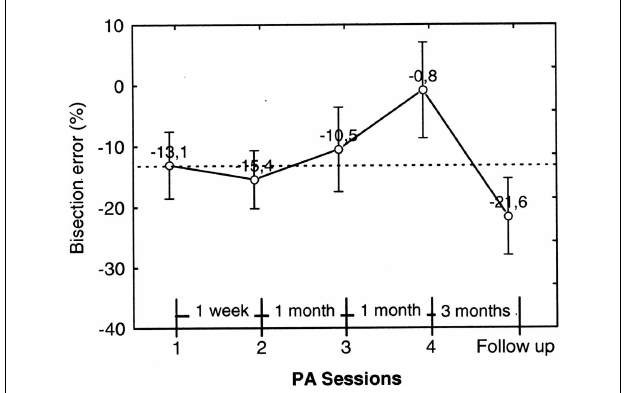
FIGURE 9 | Graphic representation of the effect of prismatic adaptation (PA) on the patient’s bisection by pointing errors in far space . Each data point represents the bisection error prior to PA.The error is significantly reduced in session 4. However, at follow-up (3months after session 4) the effect of PA is no longer present and neglect is as severe as prior to PA. Error bars represent standard errors. Bisection error is expressed as% deviation with respect to half line length. Negative and positive values indicate errors to the left and to the right of the objective midline, respectively.